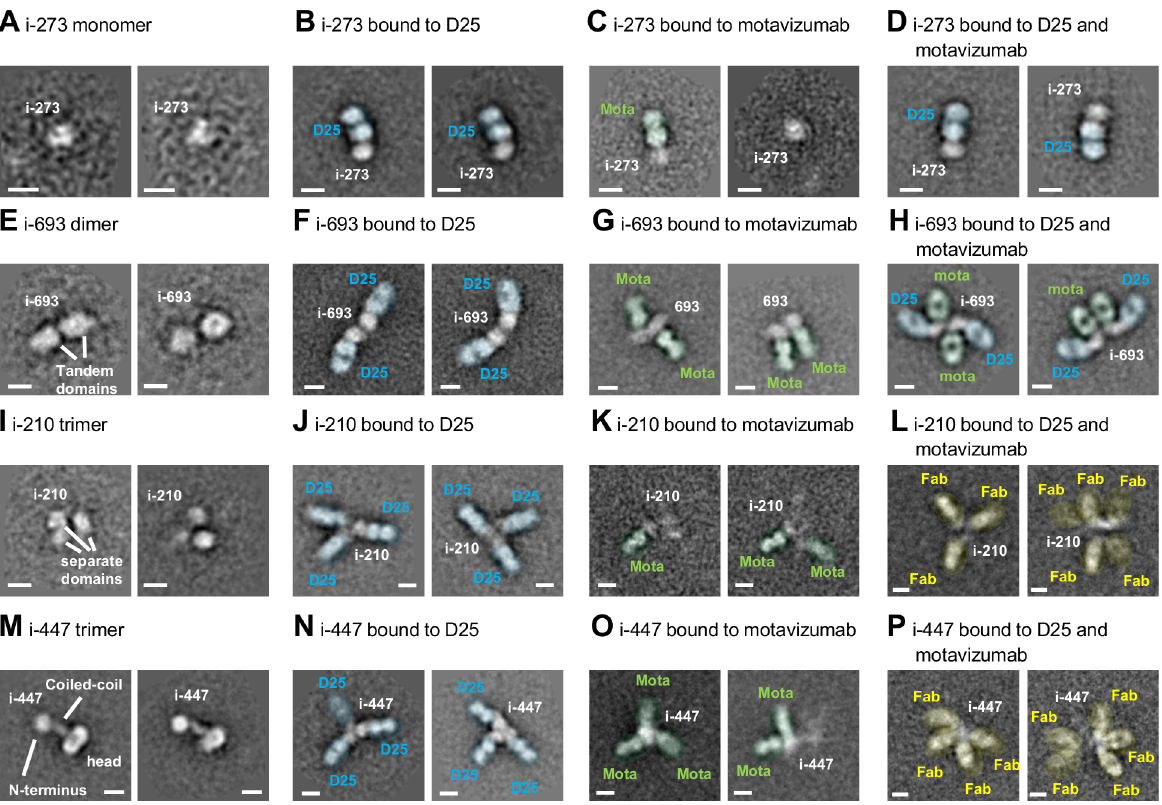
Fig 3. Negative-stain electron microscopy of head-only immunogens. Panels (A-P) show typical 2D averaged classes of i-273,i- 693, i-210 and i-447 alone (A, E, I and M) , in complex with D25 (in blue; B, F, J and N ), in complex with motavizumab (in green; C, G, K and O ) and in complex with both D25 and motavizumab (in blue, green; D, H, L and P ). Yellow indicates Fabs of ambiguous identity. Two separate averages are shown for each panel. White scale bars are 50 Å